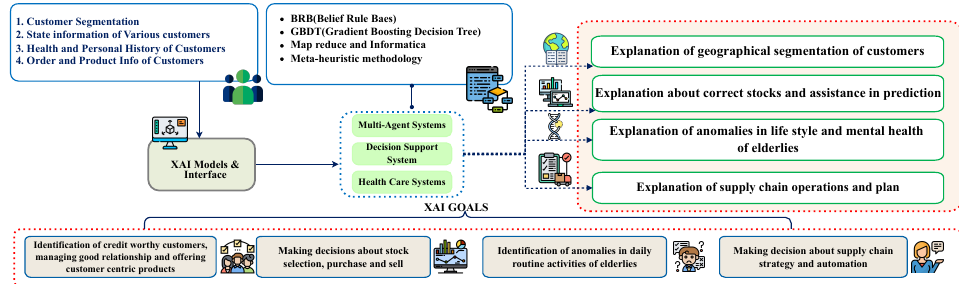
Figure 5. A Usecase of XAI with Big Data for Smart